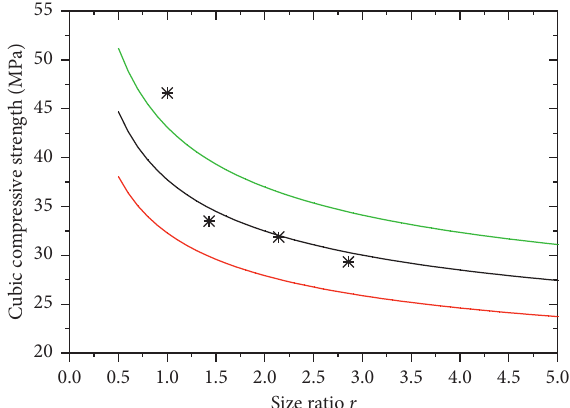
Figure 7: Fitting curves of size effect laws for compressive strength.